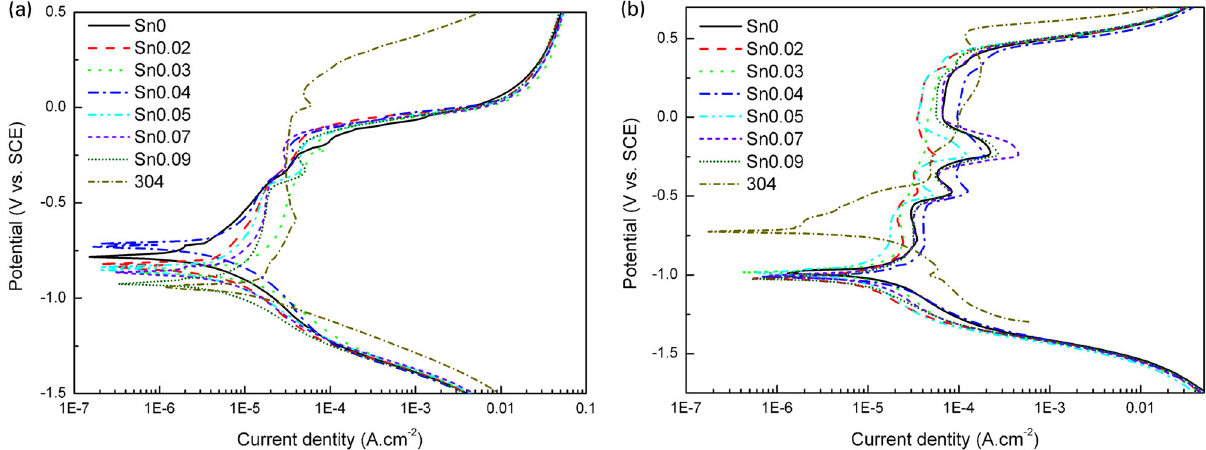
Fig. 13 Potentiodynamic polarisation curves of the FeCoNiCuSn x system and 304 SS in a 3.5 % NaCl; b 5 % NaOH ( a – b reprinted from ref. 69 by permission of Taylor and Francis Ltd, copyright The Institute of Materials, Minerals and Mining)